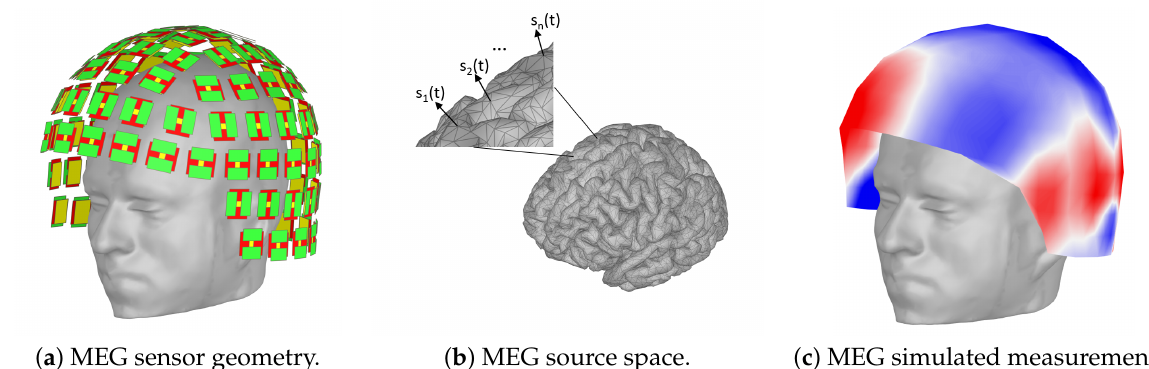
Figure 4. Simulation of MEG data for deep learning localization. ( a ) Simulations used the anatomy of an adult human subject and a whole-head MEG sensor array from an Elekta Triux device. ( b ) Cortical sources with time course s i ( t ) were simulated at different cortical locations. ( c ) The activated cortical sources yielded MEG measurements on the cortex that, combined with additive Gaussian noise, comprised the input to the deep learning